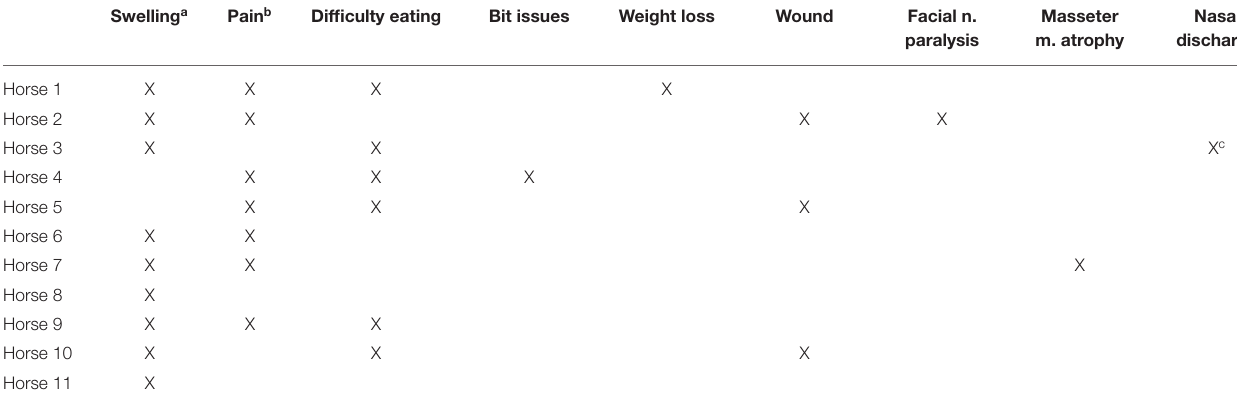
TABLE 2 | Clinical signs on